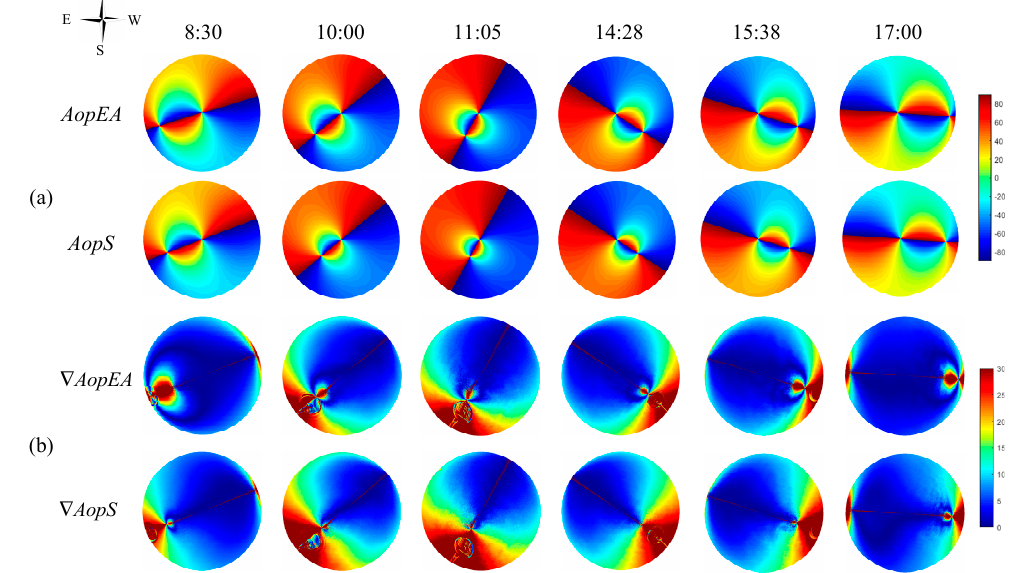
Figure 11. The consistency representation of the actual measurement, simulation in equisolid angle imaging and stereographic imaging mode; ( a ) the simulation of AopEA and AopS , where AopEA represents the two-dimensional simulation of the equisolid angle imaging of the Rayleigh model, and AopS represents the simulation of the stereographic imaging method in the Rayleigh model; ( b ) the consistency of the simulation with the actual measurement; where, (cid:12) (cid:12) (cid:12) (cid:12) (cid:12) (cid:12) (cid:12) (cid:12) ∇ AopEA = (cid:12) AopEA ( i , j ) − Aop ( i , j ) (cid:12) and ∇ AopS = (cid:12) AopS ( i , j ) − Aop ( i , j ) (cid:12) . The results of similarity and improvement at six di ff erent times from 8:30 to 17:00 are shown in Table 3. The similarity between the two-dimensional simulation of the equisolid angle imaging of the Rayleigh model and the actual measurement is called ε AopEA . Likewise, the similarity between the simulation of the stereographic imaging method and the actual measurement is known as ε AopS .